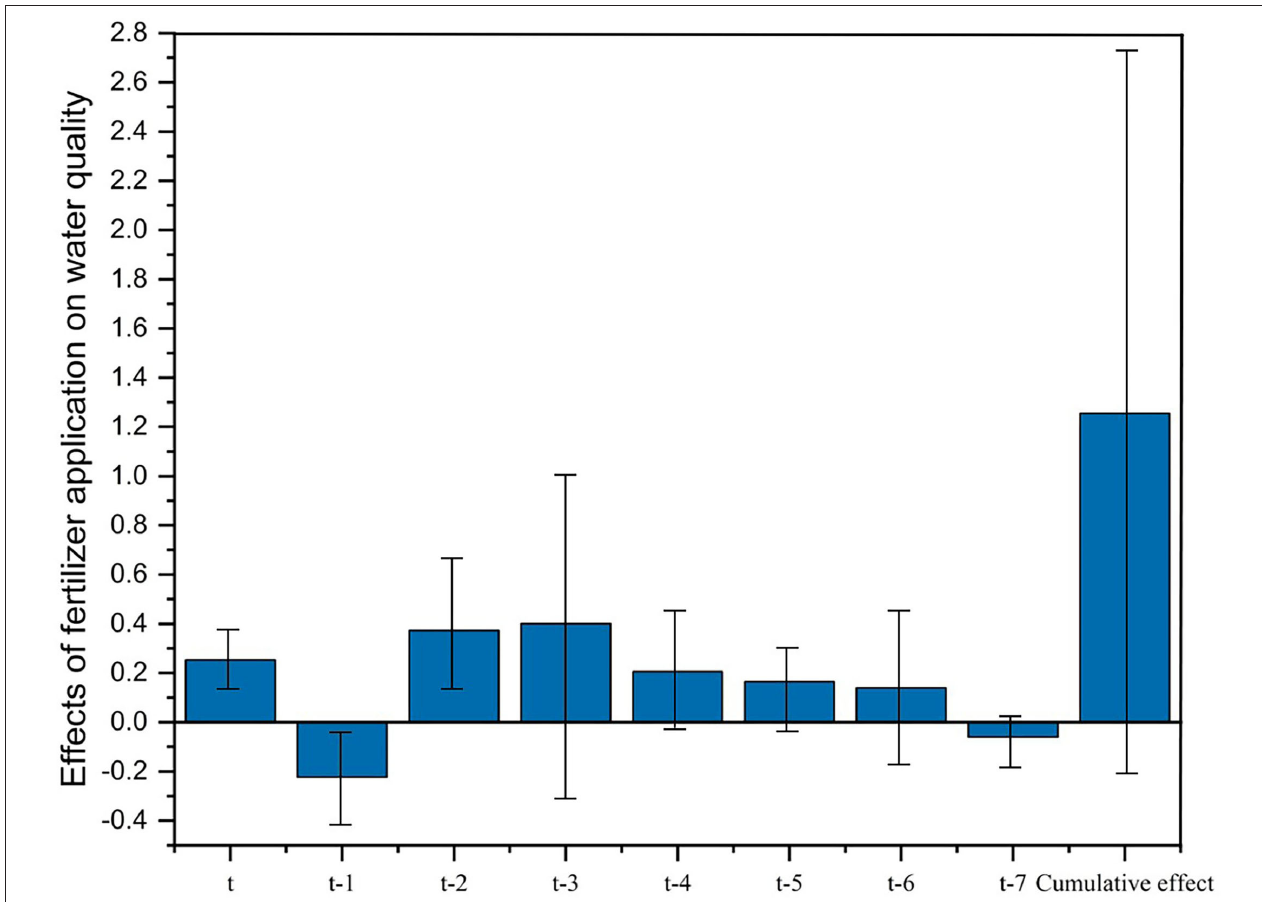
FIGURE 3 | Long-term effects of fertilizer application on water quality with 7 lagged